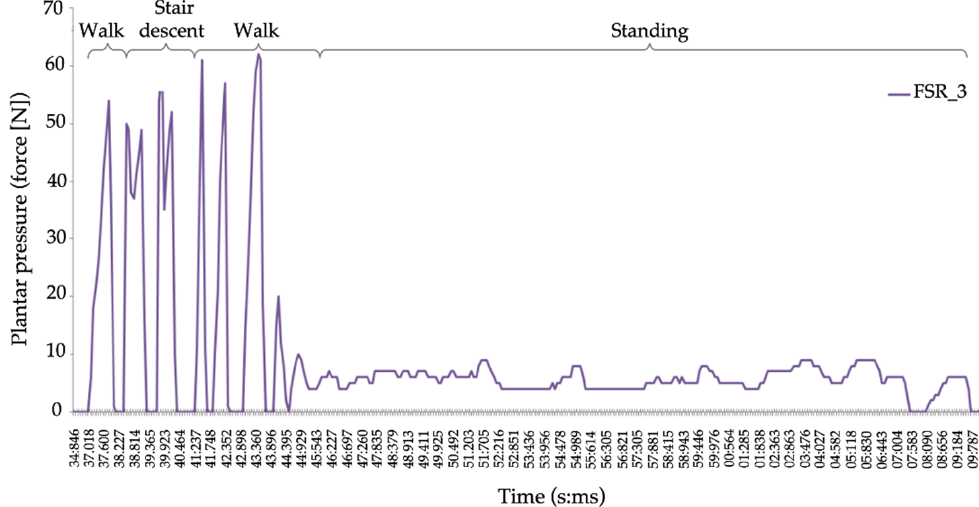
Figure 3. Sample dual-task plantar pressure was obtained from force sensitive resistor 3 (FSR_3) in the right shoe insole. This could be used to differentiate walking, stair descent and standing portions of the block. A similar procedure was used to extract the different blocks in the stair ascent conditions.